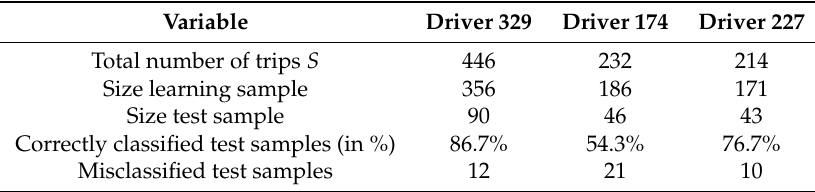
Figure 10. ( left ) Scatter plot ( σ a , σ ∆ ) of all n = 416 drivers with drivers 329, 174 and 227 in magenta, green and cyan colors; ( middle and right ) density plots of σ v , s , σ a , s and σ ∆ , s for s = 1, . . . , S of the three drivers 329, 174 and 227. Table 3. Out-of-sample analysis of drivers 329, 174 and 227.